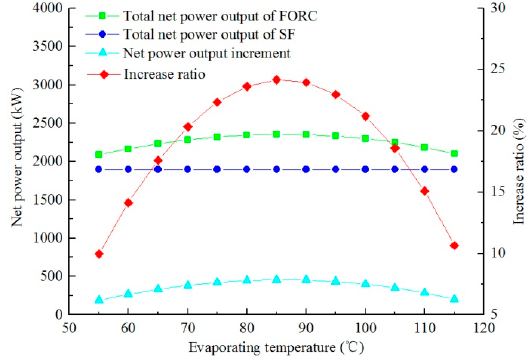
Figure 6. Variations of net power output of FORC with evaporating temperature (geofluid temperature = 130 °C ; steam dryness = 0.2; geofluid flow rate = 150 t/h).